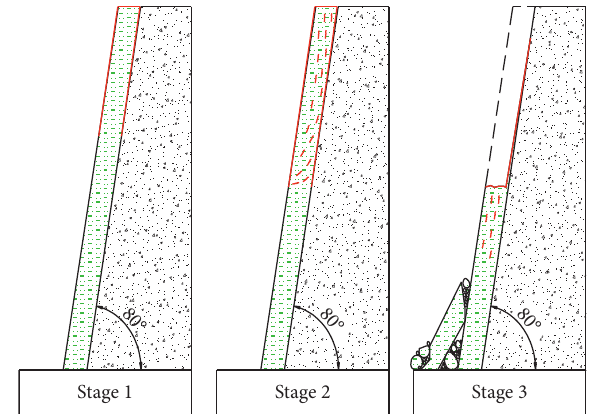
Figure 18: Schematic diagram of the instability evolution process of the slope substrate